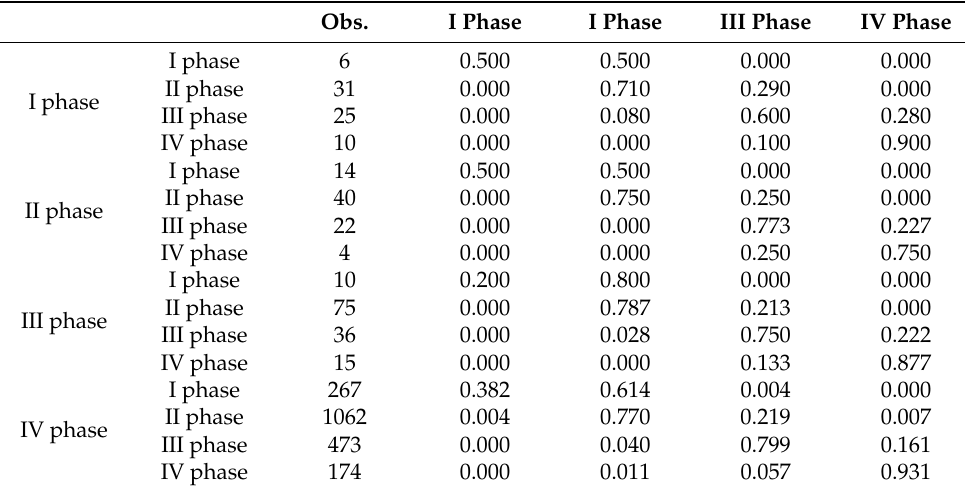
Table 5. Spatial Markov transition probability of the digital economic level.